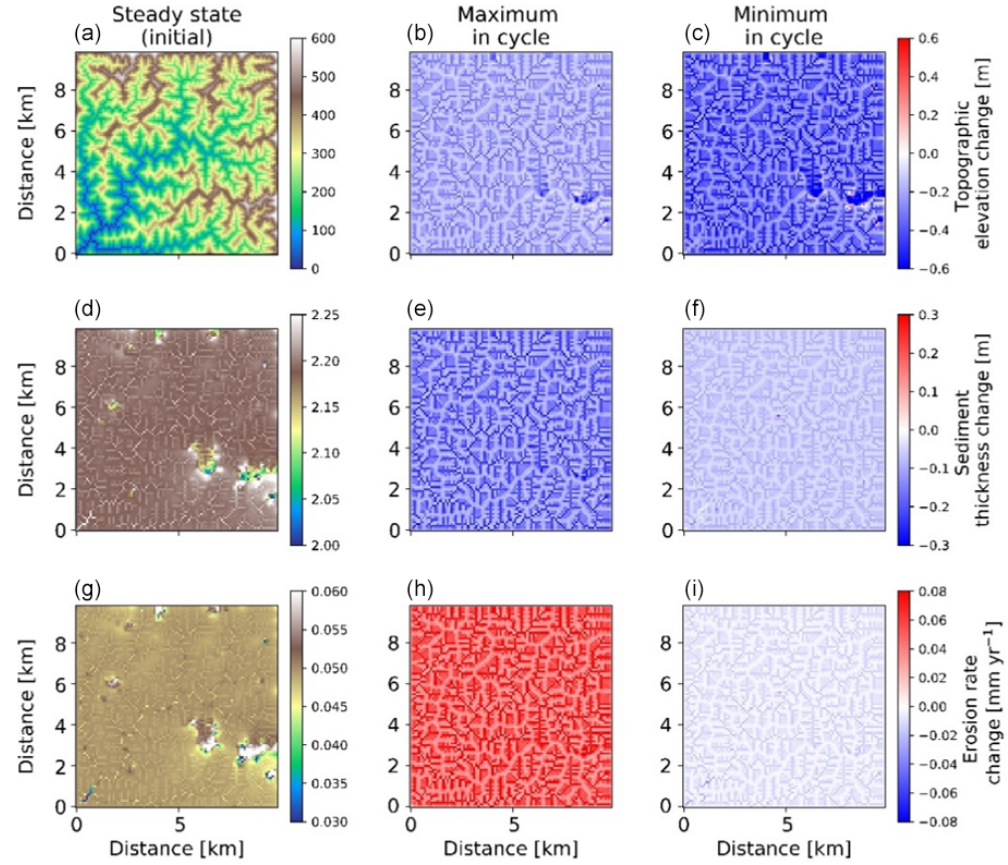
Figure 13. Two-dimensional map-view representation of changes in topographic elevations [m] (a–c) , sediment thickness [m] (d–f) , and erosion rates [mmyr − 1 ] (g–i) . These changes are represented with respect to steady-state conditions (a, d, g) for maximum (b, e, h) and minimum (c, f, i) values of precipitation and vegetation in an oscillation cycle. The simulations represent 70% initial vegetation